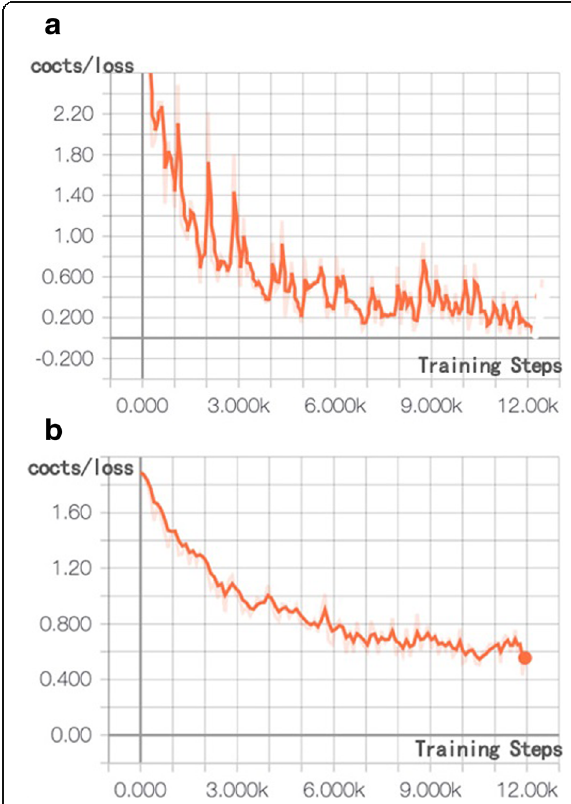
Fig. 3 Comparison of loss function curves under WRN and GoogleLeNeT Inception V4.